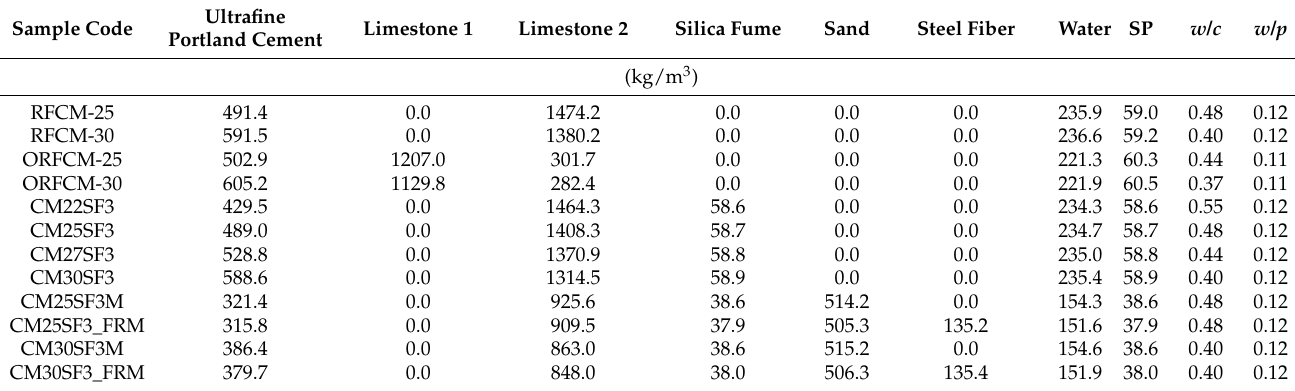
Table 3. Mix proportion of designed reverse filling paste and